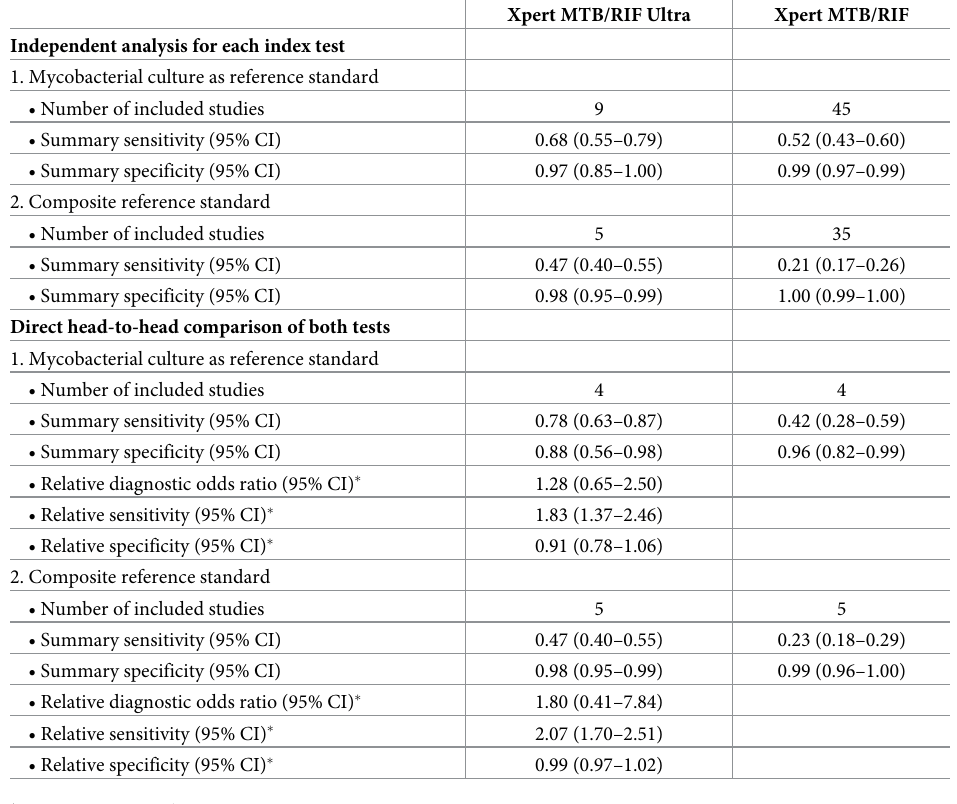
Table 1. Summary diagnostic accuracy parameters and their